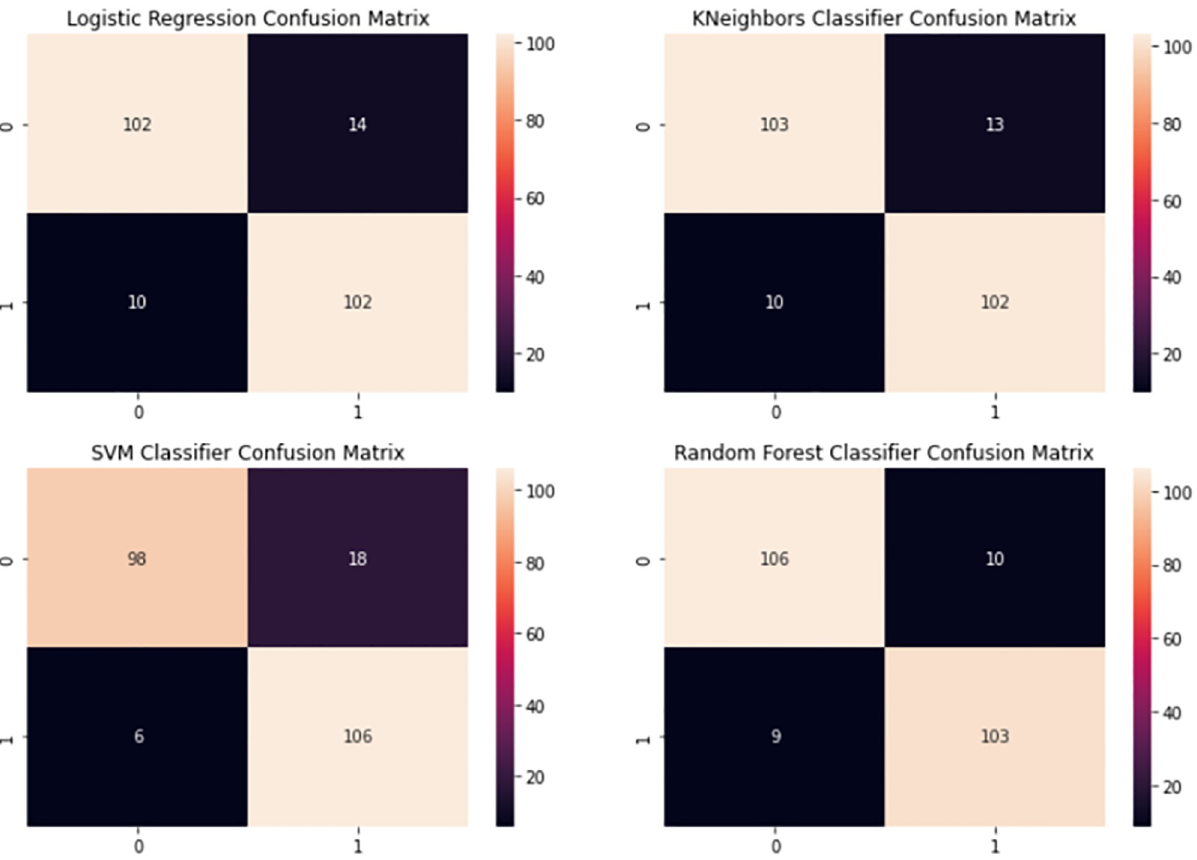
Fig 5. The confusion matrix shows the accuracy of traditional machine learning algorithms. The correctly classified data is reflected along the diagonal regions. The misclassified is reflected in the off-diagonal regions. Top-left plot logistic regression confusion matrix, top-right plot k-nearest- neighbors confusion matrix, bottom-left plot support vector machines confusion matrix, and bottom-right plot random forest confusion matrix.